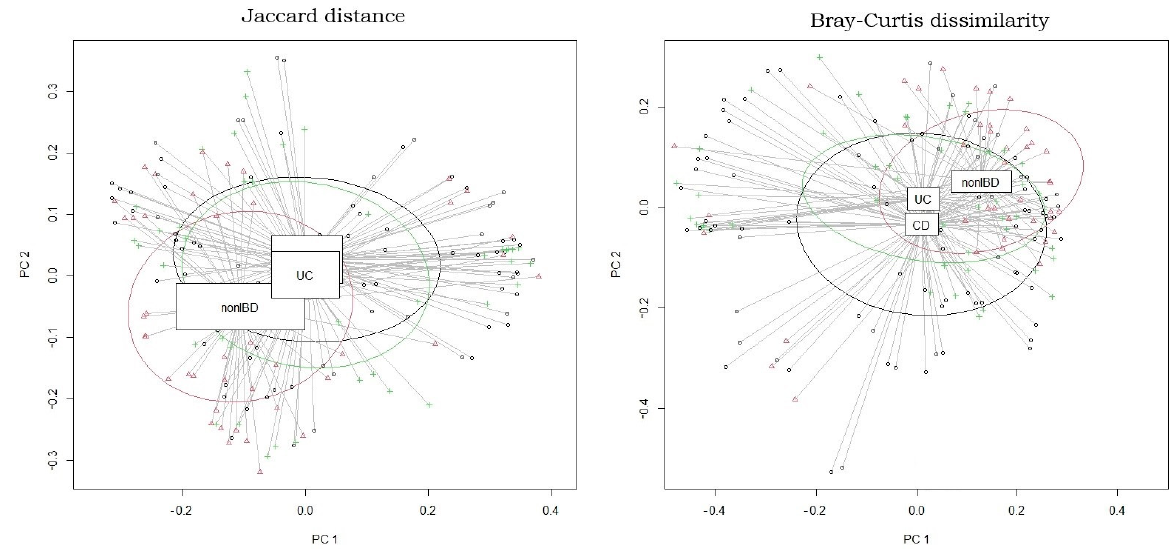
Figure 2. Beta diversity for the IBD dataset. Jaccard distance vs. Bray–Curtis dissimilarity. Once β diversity has been measured, the dataset can be visualised by principal coordinate analysis (PCoA). PCoA is an ordination technique widely described in the literature for analysing the composition of different microbiomes. β diversity analysis elucidate dissimilarities between samples (UC, CD and healthy). Figure generated using